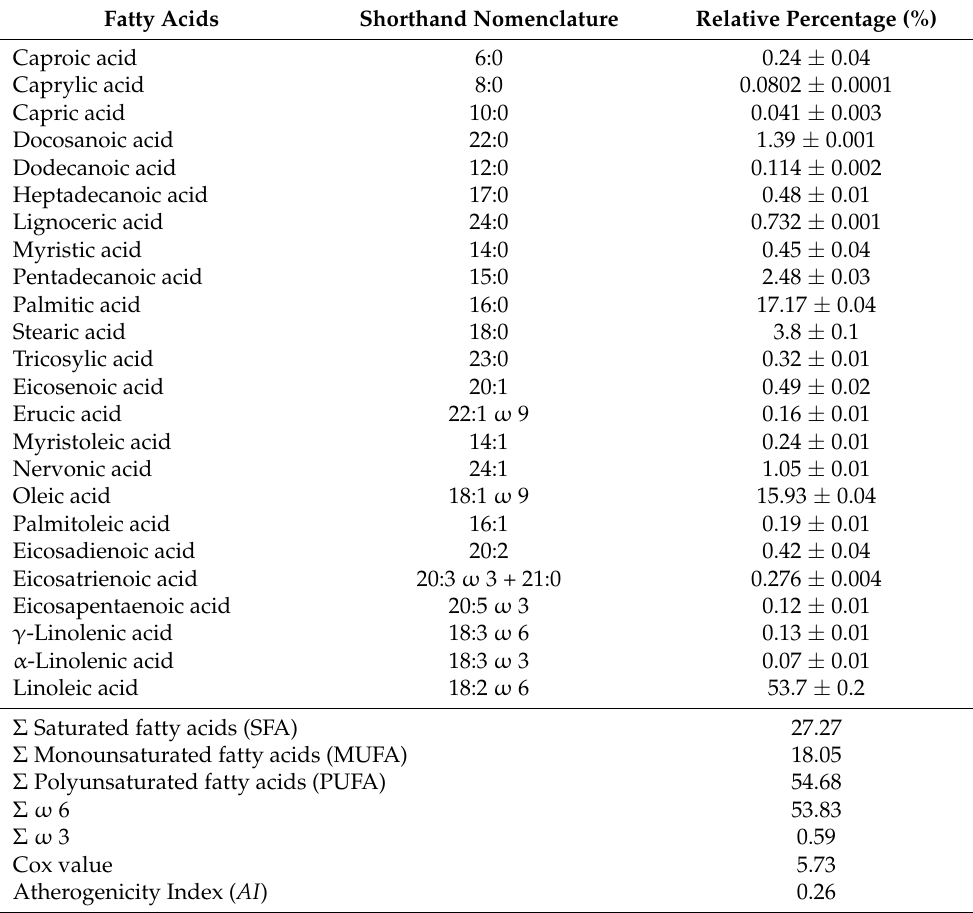
Table 1. Fatty acid composition of B. officinalis flower extract.